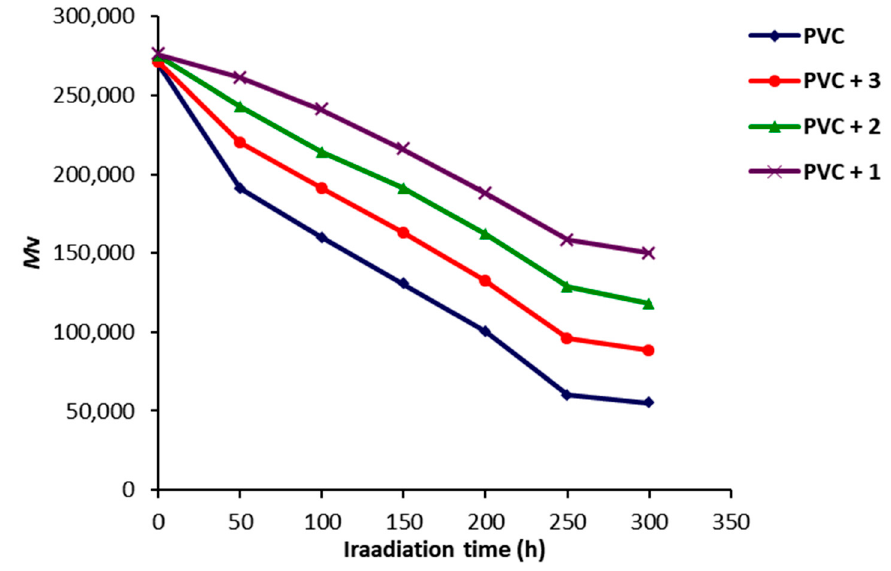
Figure 7. Effect of irradiation of PVC films on (cid:1839)(cid:3365) (cid:2906) .